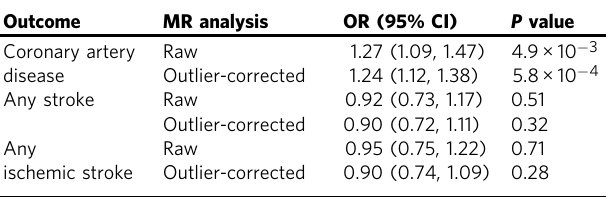
Table 4 MRPRESSO analysis of relationship between prediabetes and outcomes with detected